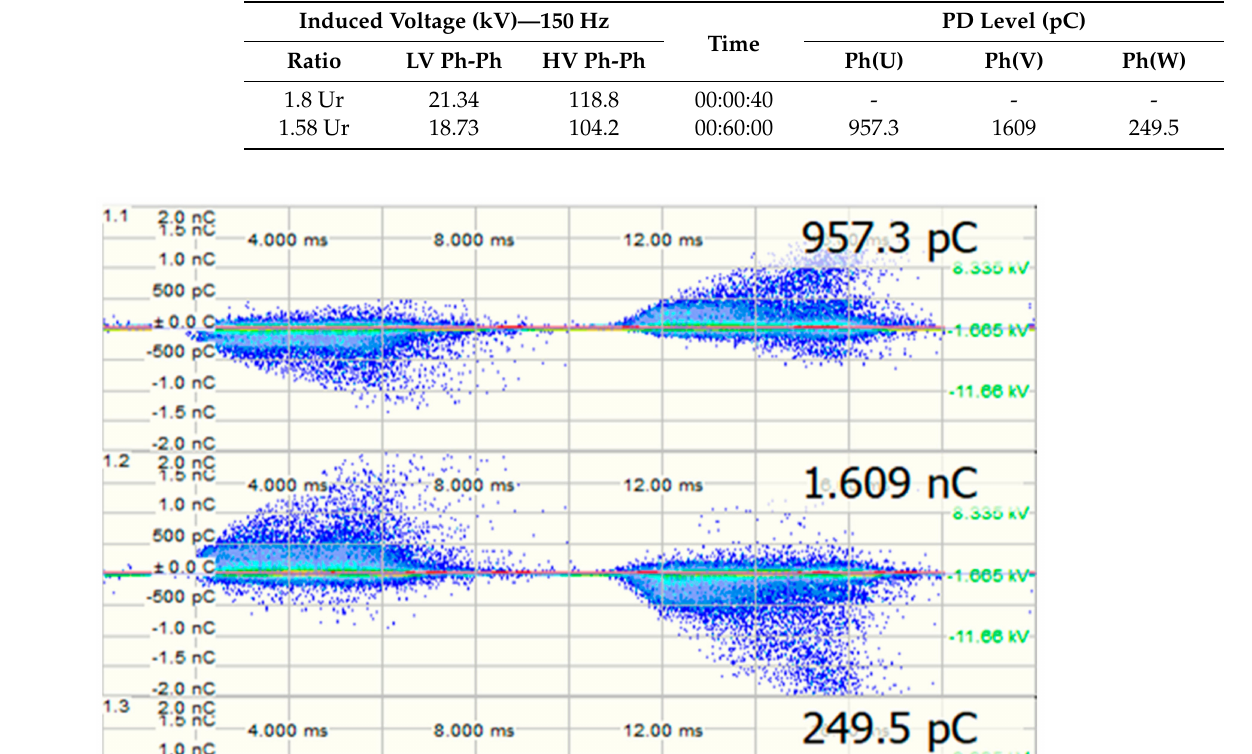
Table 8. Induced voltage test with PD measurement (IVPD) before oil terminated.